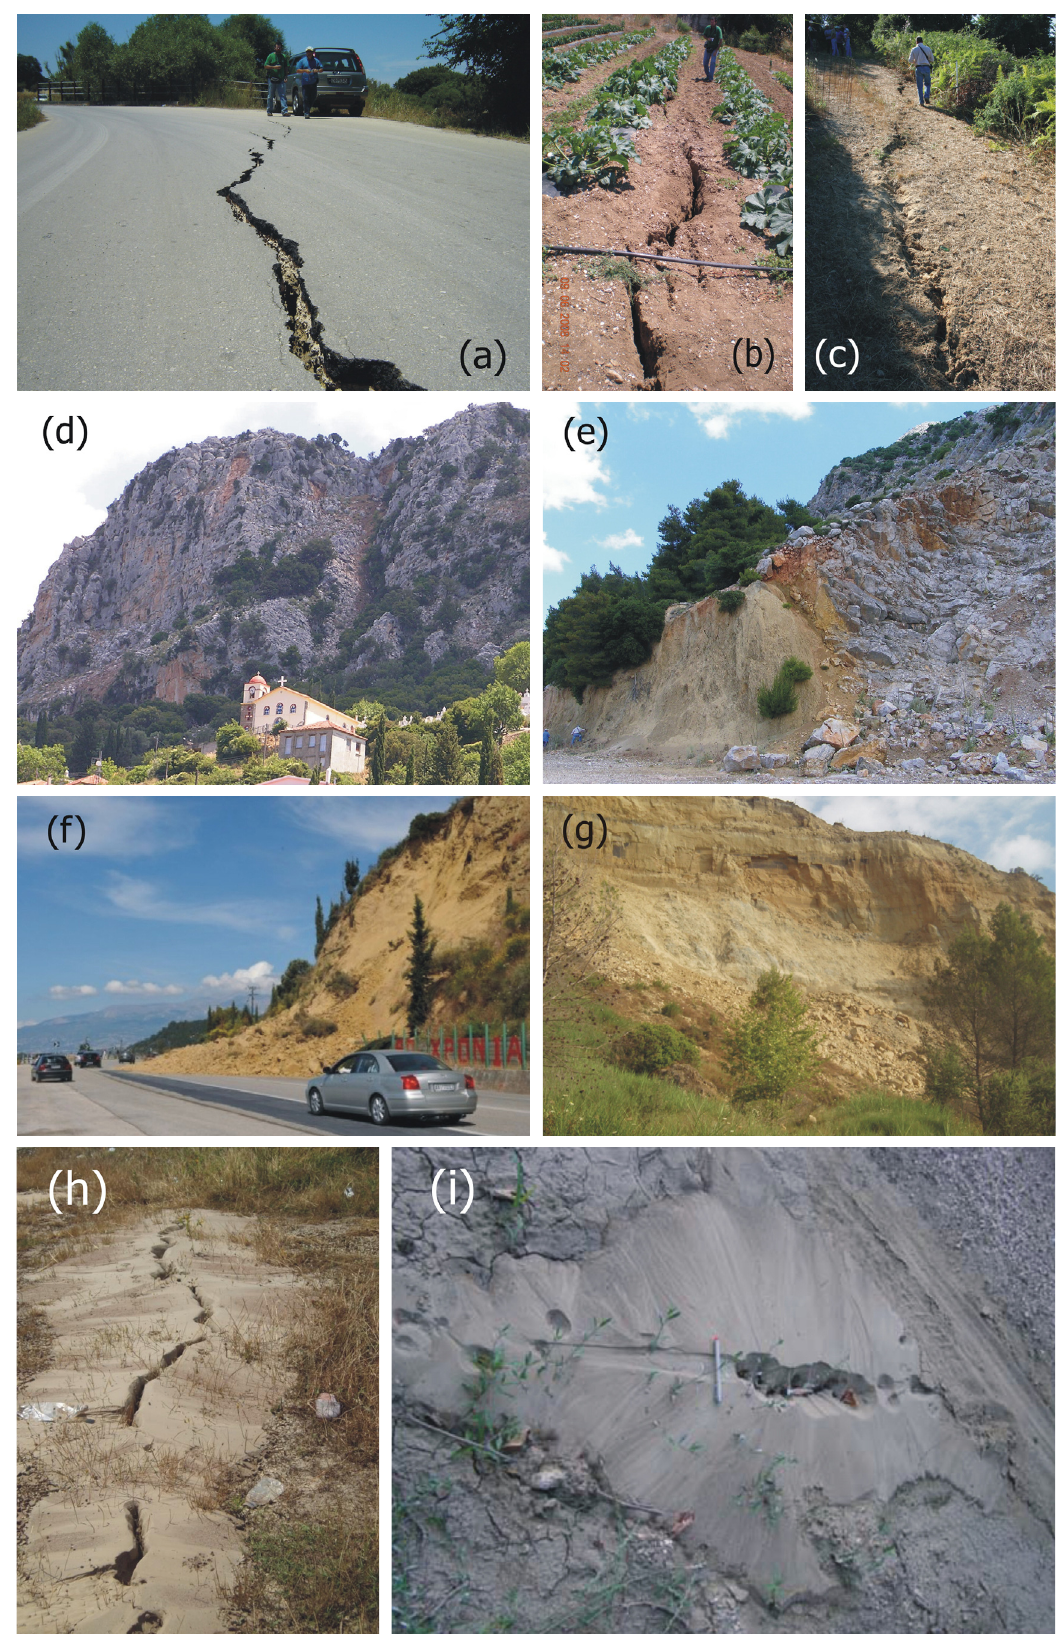
Figure 3. View of the most characteristic 2008 Andravida EEE. (a, b, c) NW-SE trending transverse surface fractures were observed in the Nissi area. (d, e) Rock toppling failures of limestones took place at the western foothills of Skolis Mt, in the Santomeri (d) and the Portes (e) villages. (e) Cretaceous carbonates overthrust shaly flysch at the western steep slopes of Skolis Mt. The flysch strata close to the thrust sur- face are steeply dipping and overturned. (f) Landslides and failures of artificial slopes took place along the national roads of the study area (Vrachneika). (g) Landslide along the road from the Portes to the Valmi village. (h) Surface fractures and flows of liquefied material ob- served in the Kato Achaia area. (i) Sand boils in the Nissi